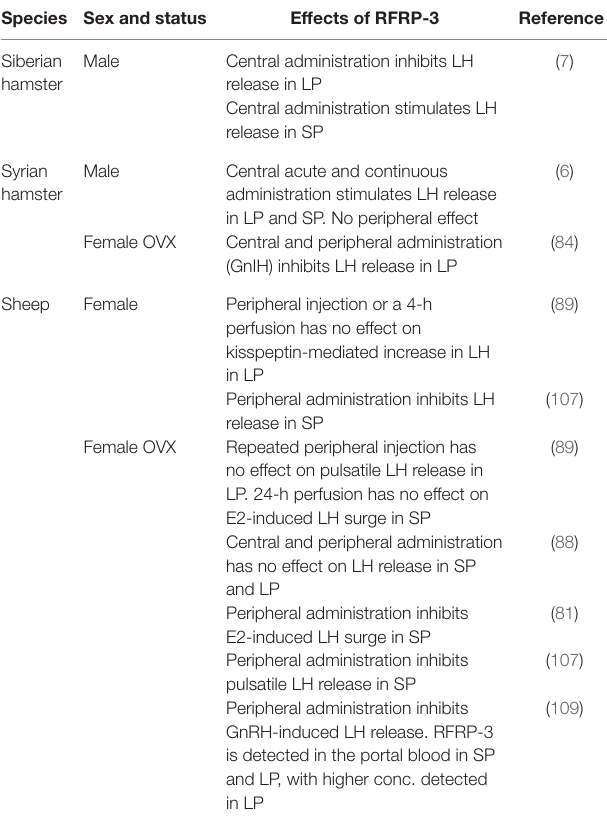
TABLe 1 | Overview of the in vivo effects of RFRP-3 on reproduction in seasonal